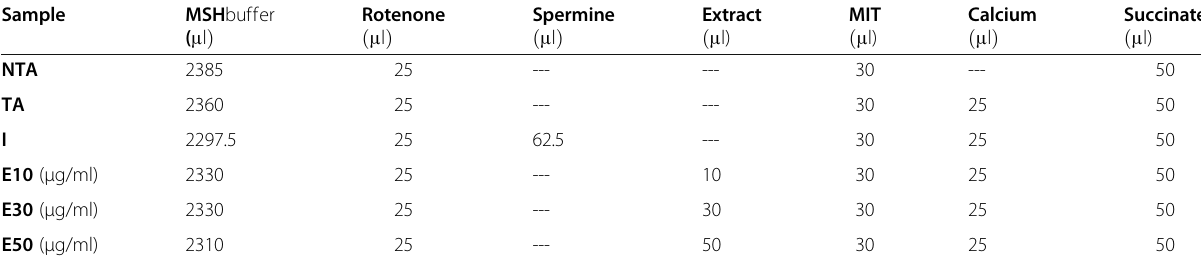
Table 1 Procedure for the assay of mitochondrial membrane transition pore in rat liver mitochondria (MMPT)